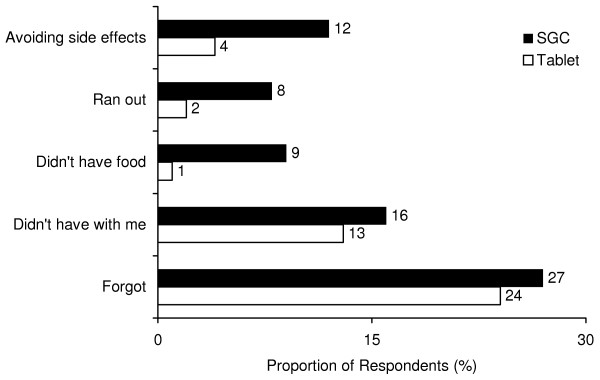
Reasons for non-adherence in patients switched from SGCs BID to tablets BID.